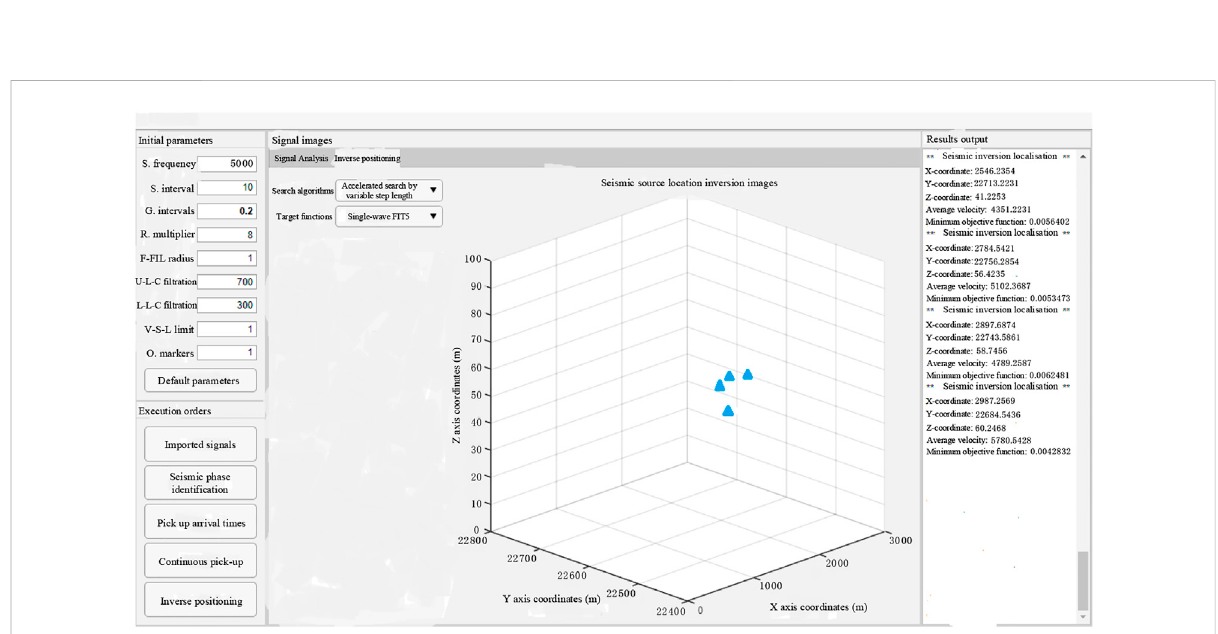
FIGURE 17 Software calculation of the microseismic localization results for the April 10